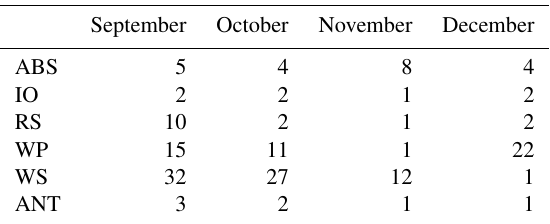
Table 1. Rank of regional sea ice extent from September to Decem- ber